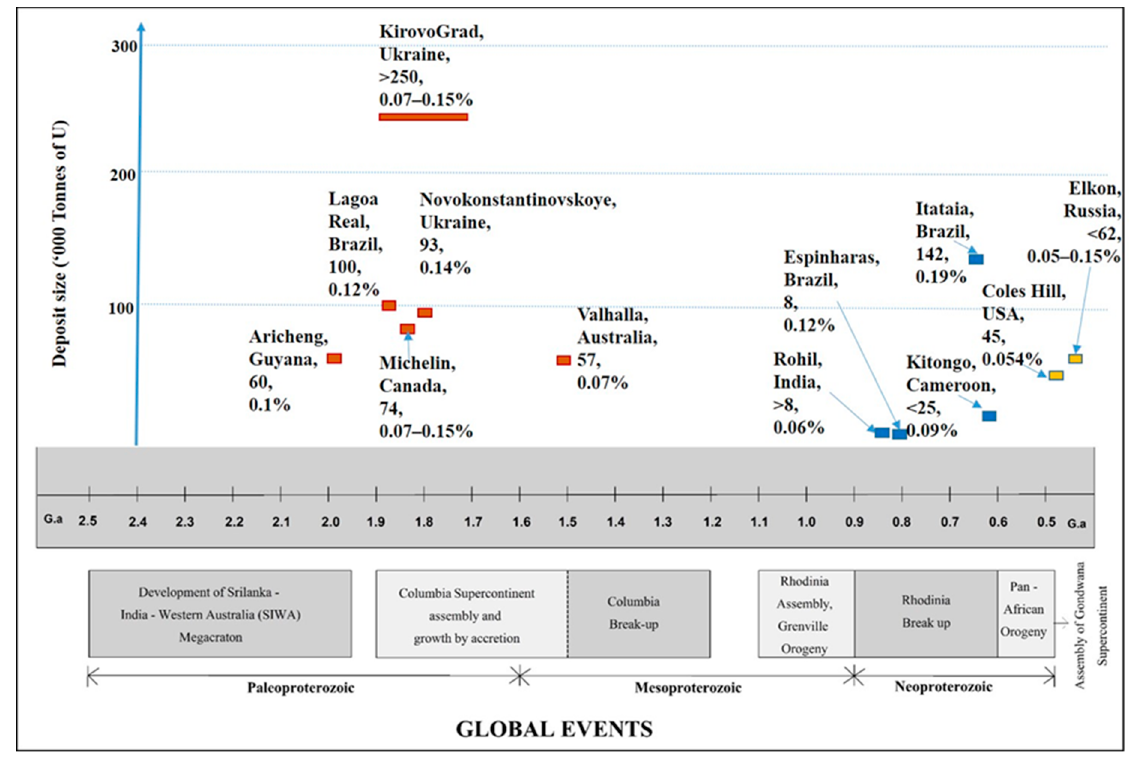
Figure 13. Global metasomatite-type uranium deposits vis-s-vis global events in geological history. Uranium deposits proliferated during the Columbia supercontinent assembly during the Palaeoproterozoic period and waned during the Rhodinia breakup in the Neoproterozoic period and again started to proliferate during the Gondwana supercontinent assembly post-Pan-African Orogeny. The Rohil polymetallic uranium deposit represents the waning peak of the mineralisation episode in terms of both tonnage and grade.